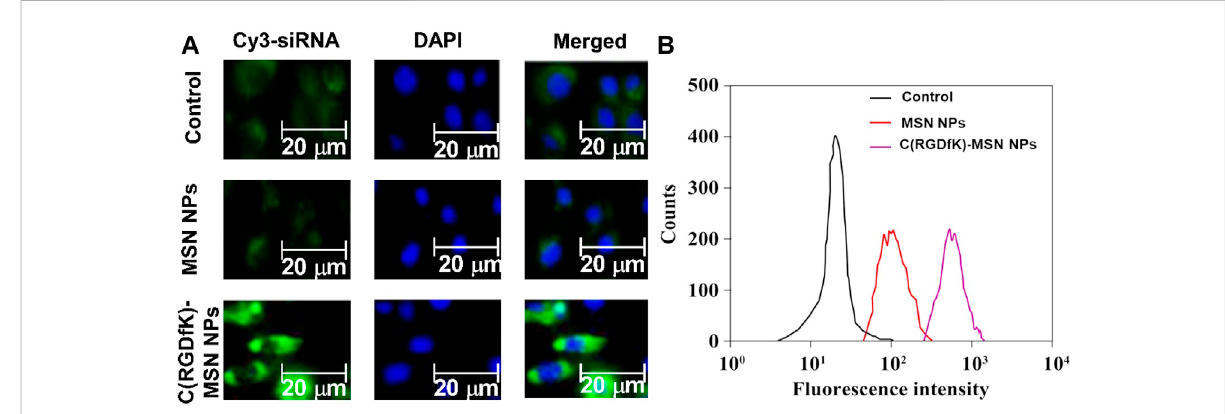
FIGURE 4 (A) Confocal microscopy images ofT24cells after incubationwith MSNs-Cy3-siRNA andc(RGDfK)-MSNs-Cy3-siRNAfor 6 h(green, Cy3;